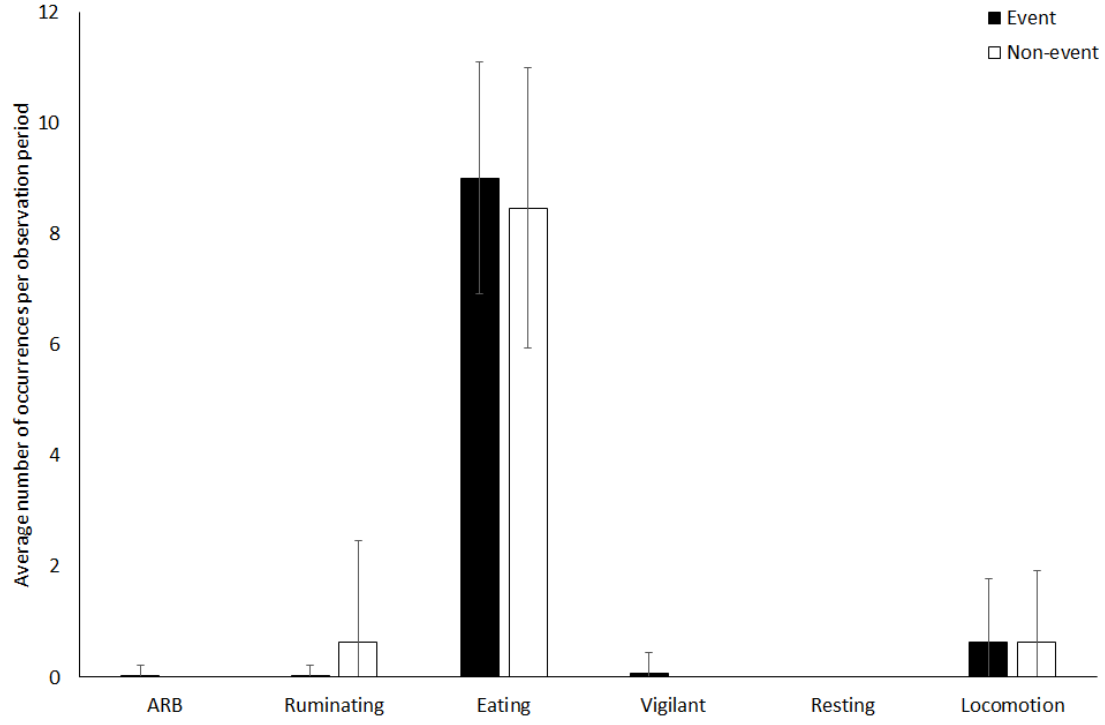
Figure 8. Activity budget data from 16:00 to 20:00 for two giraffes (average number of occurrences of each behaviour within the group per observation period ± standard deviation) on event nights and non-event nights at Knowsley Safari. ARB: abnormal repetitive behaviour, OOS: out of sight of the observer.